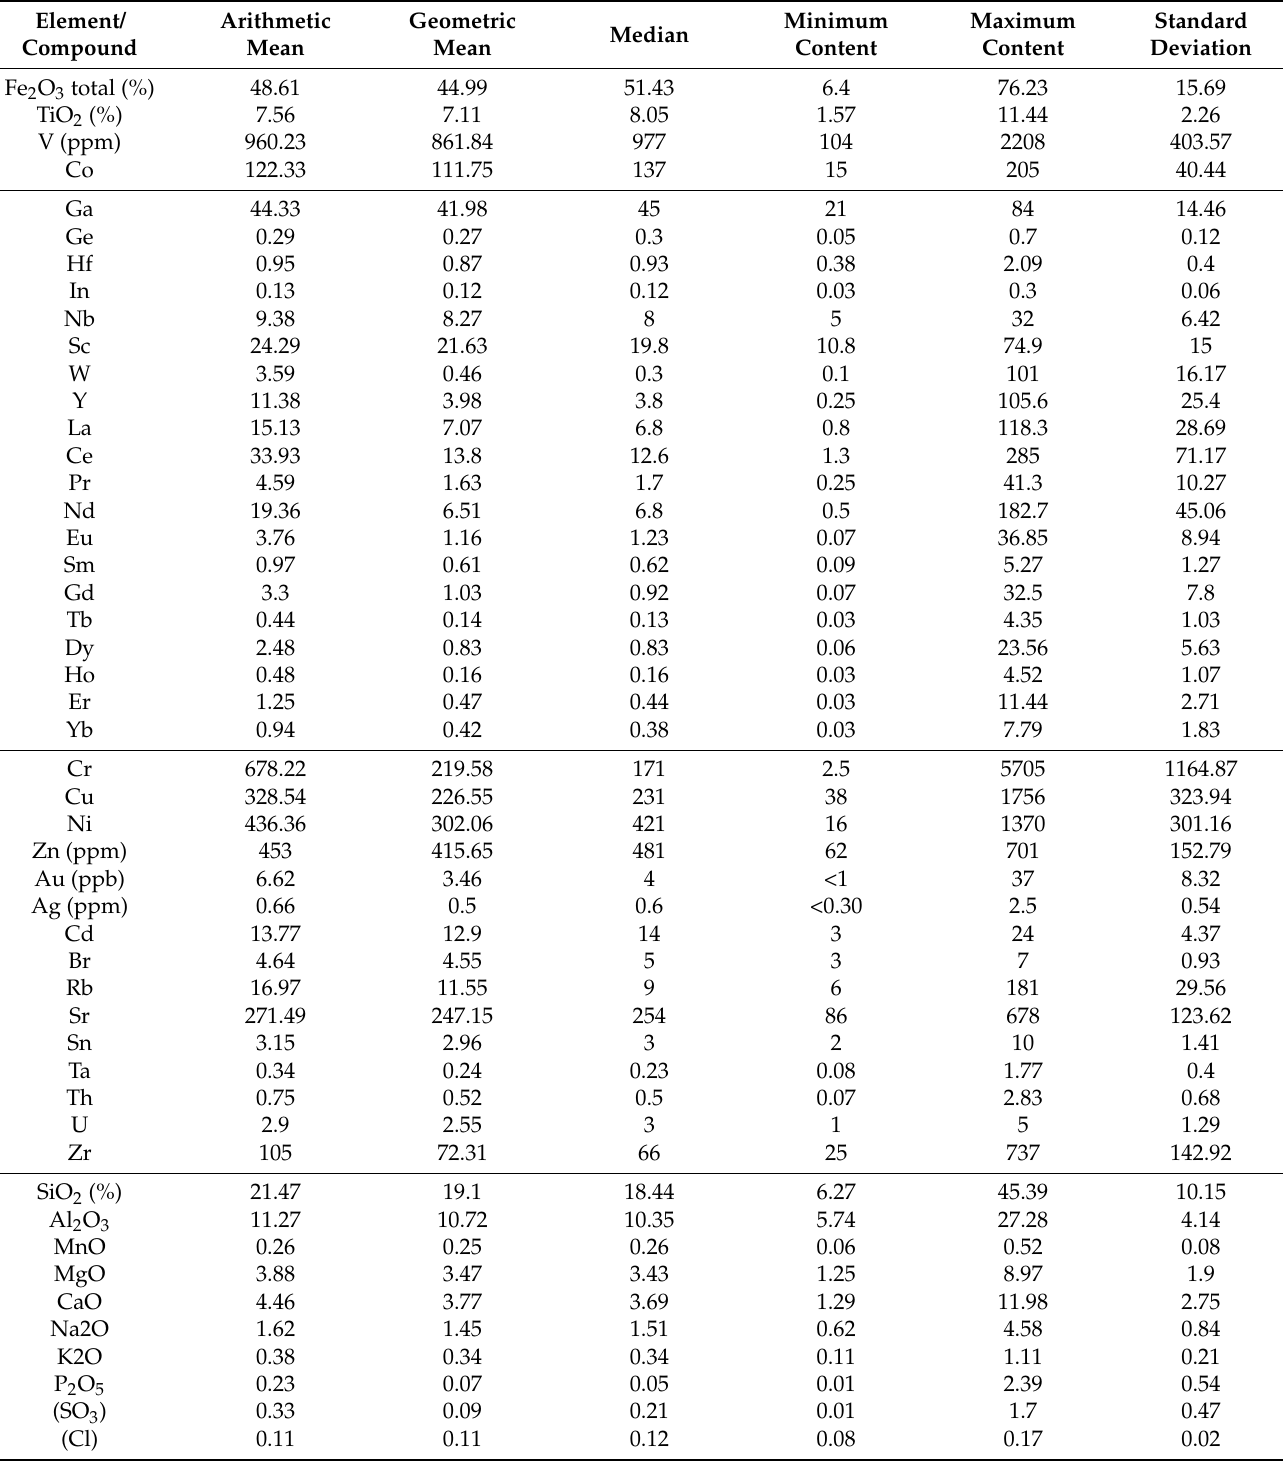
Table 7. Basic statistical parameters for trace elements (in ppm, and in ppb for Au, Pt, and Pd) and major oxides (as a percentage) of the bulk-rock samples ( n = 39) from the Fe-Ti-V oxide deposits